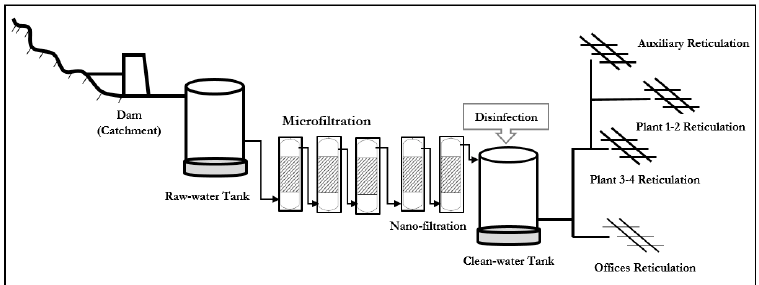
Figure 2. Schematic layout of the drinking water supply system.